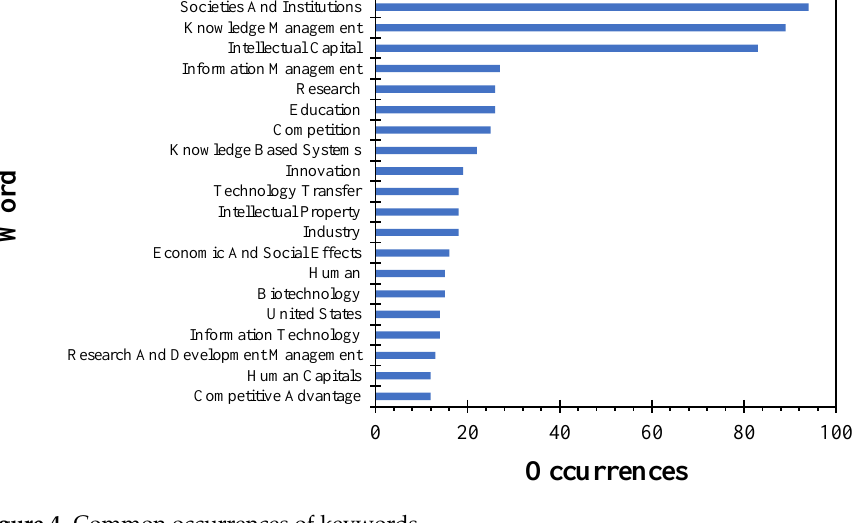
Figure 4. Common occurrences of keywords.